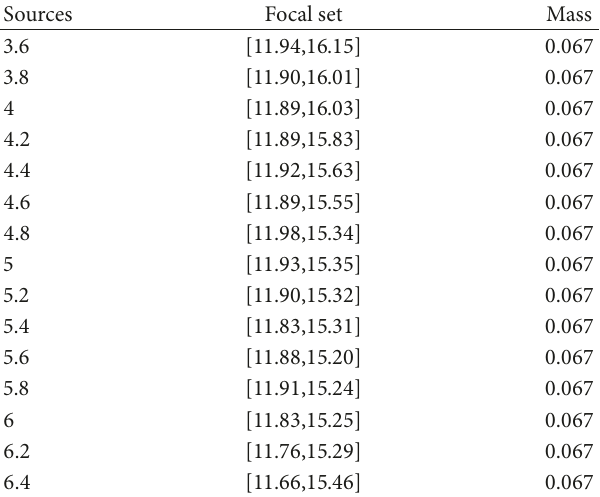
Table 2: Random sets and mass assignment for different threshold. Sources Focal